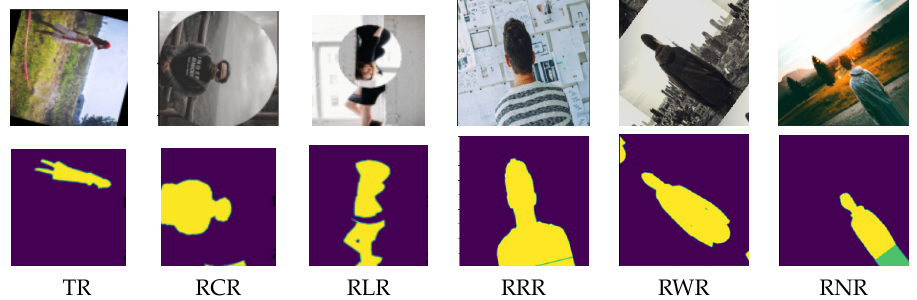
Figure 17. Samples of the Supervisely Person dataset by applying the RLR, TR, RCR, RRR, RWR and RNR augmentation techniques. Rows one and two are the augmented samples with their corresponding human body segmentation, respectively.